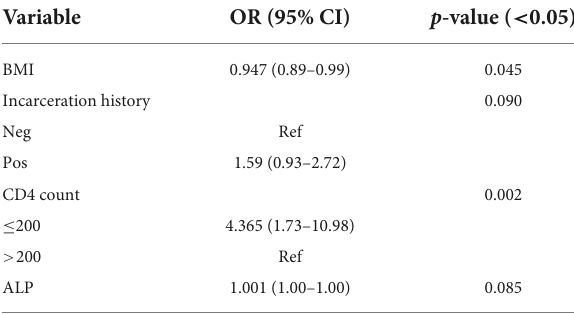
TABLE 4 The important risk factors for oral Candidiasis (multiple logistic